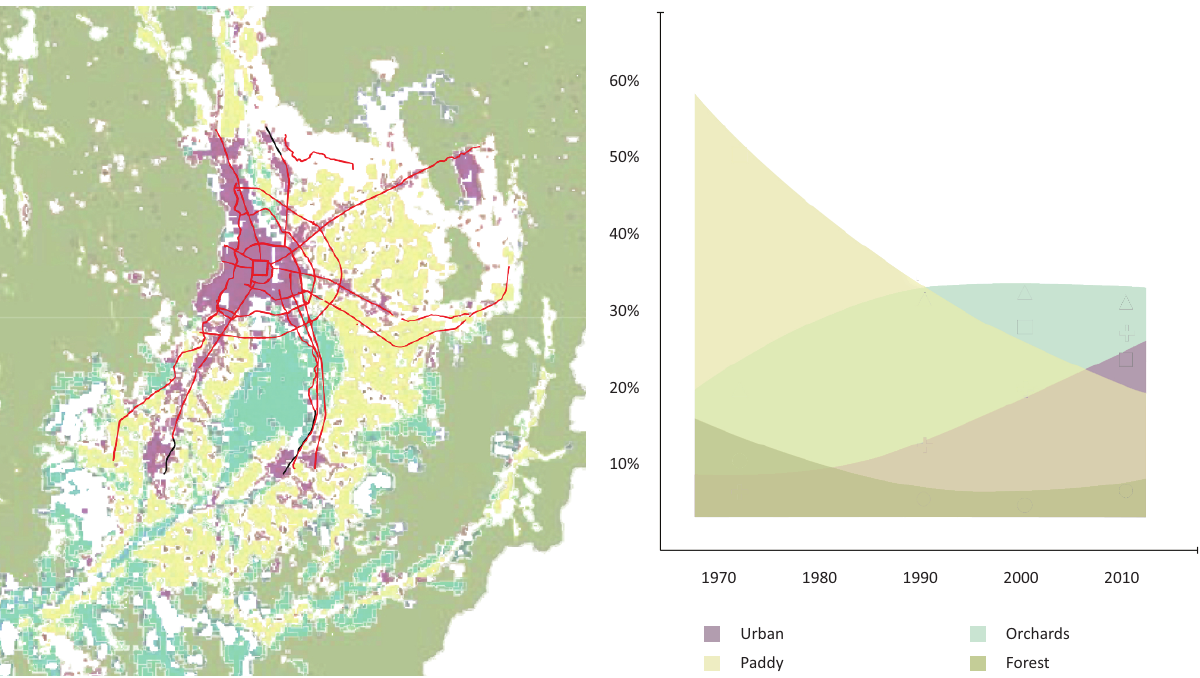
Figure 7. Chiang Mai/Lamphun Valley showing the major land cover types. The graph indicates Sangawongse’s land use doc- umentation of the comprehensive planning boundary. A rice paddy and forested dominated region has recently evolved to one where there is a balance between urban area, orchard, paddy and forest patches. Agricultural map underlay adapted from M. Ekasingh, Chiang Mai University Multiple Cropping Center.